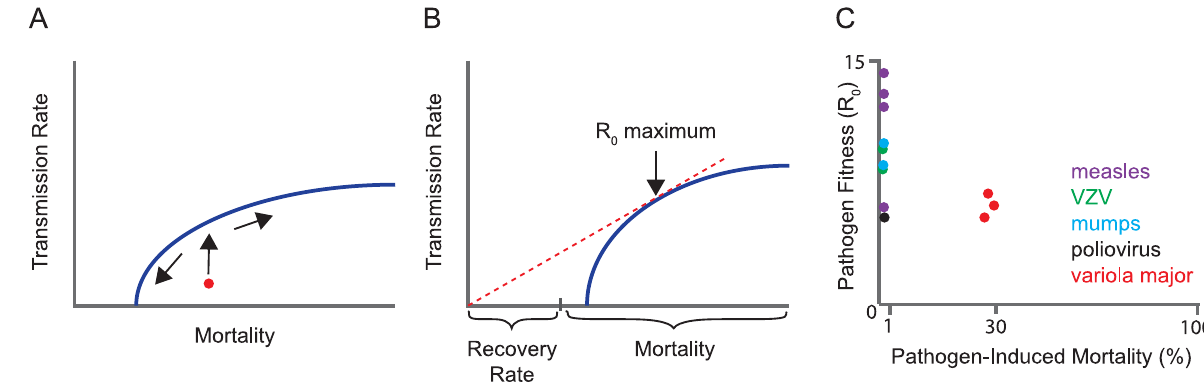
Figure 1. Trade-off models for virulence evolution. (A) A typical trade-off curve for virulence evolution, in this case between transmission rate and host mortality. The trade-off curve is a boundary on the mortality rate and transmission rate that the parasite can evolve. If the characteristics of the pathogen initially lie underneath the trade-off curve (red circle), the early evolution will be toward the boundary, and then along it, shown by arrows. (B) Parasite fitness (R 0 ) is proportional to the ratio of transmission rate over the sum of recovery rate and mortality rate. By displacing the trade-off curve along the horizontal axis by an amount equal to the rate of recovery, the R 0 of any point on the trade-off curve is simply the slope of the line from the origin to the point. The maximum R 0 is thus achieved at the tangent of a line through the origin, as shown. This figure illustrates how the choice of the trade-off function affects what can be concluded about the evolution of virulence (mortality). Although recovery rate affects the optimum parasite fitness (R 0 ), recovery is unaffected by evolution when it is not part of the trade-off (as shown here). However, if the trade-off instead was between transmission and recovery (swapping recovery and mortality rates on the x-axis), evolution of parasite fitness would affect only the rate of host recovery, and there would be no predictions about host mortality. (C) Data on R 0 and pre-vaccination mortality rates for the viruses indicated (bottom) are abstracted from [16,17] and references therein. VZV, Varicella zoster virus.